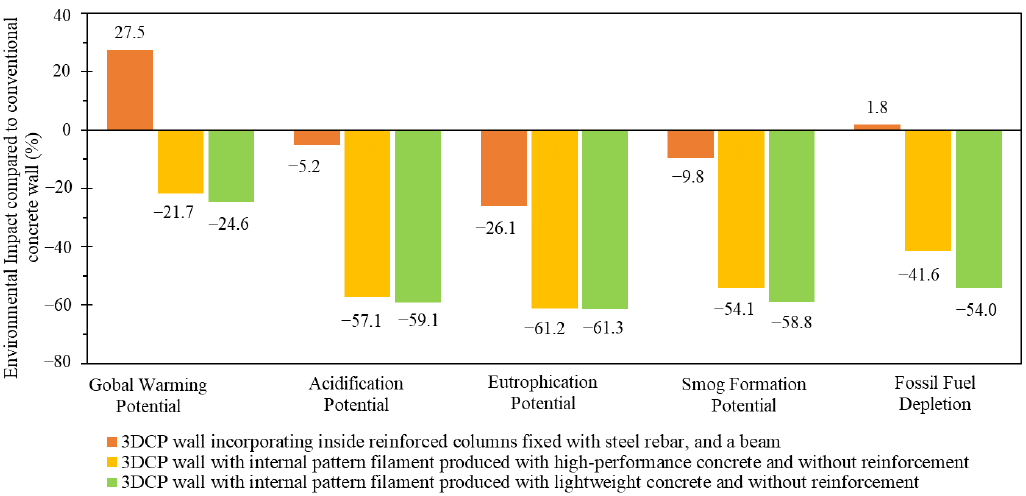
Figure 3. Environmental impact (%) by category of three 3DCP scenarios compared with the refer- ence value of construction of the conventional wall (data source